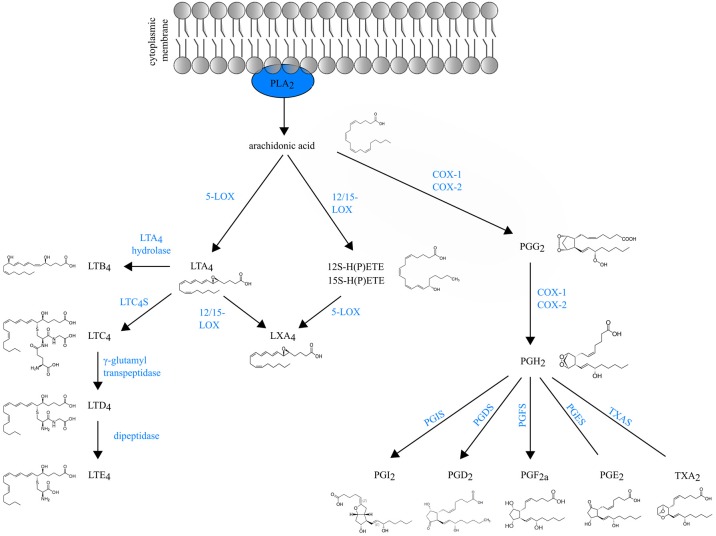
Schematic overview of eicosanoid biosynthesis. Arachidonic acid that is released from membrane phospholipids by cytosolic phospholipase A2 (PLA2), can be enzymatically converted either to prostaglandins (PG) and thromboxane (TXA2) by COX enzymes or to LT and lipoxins (LXA4) by lipoxygenases (LOXs).